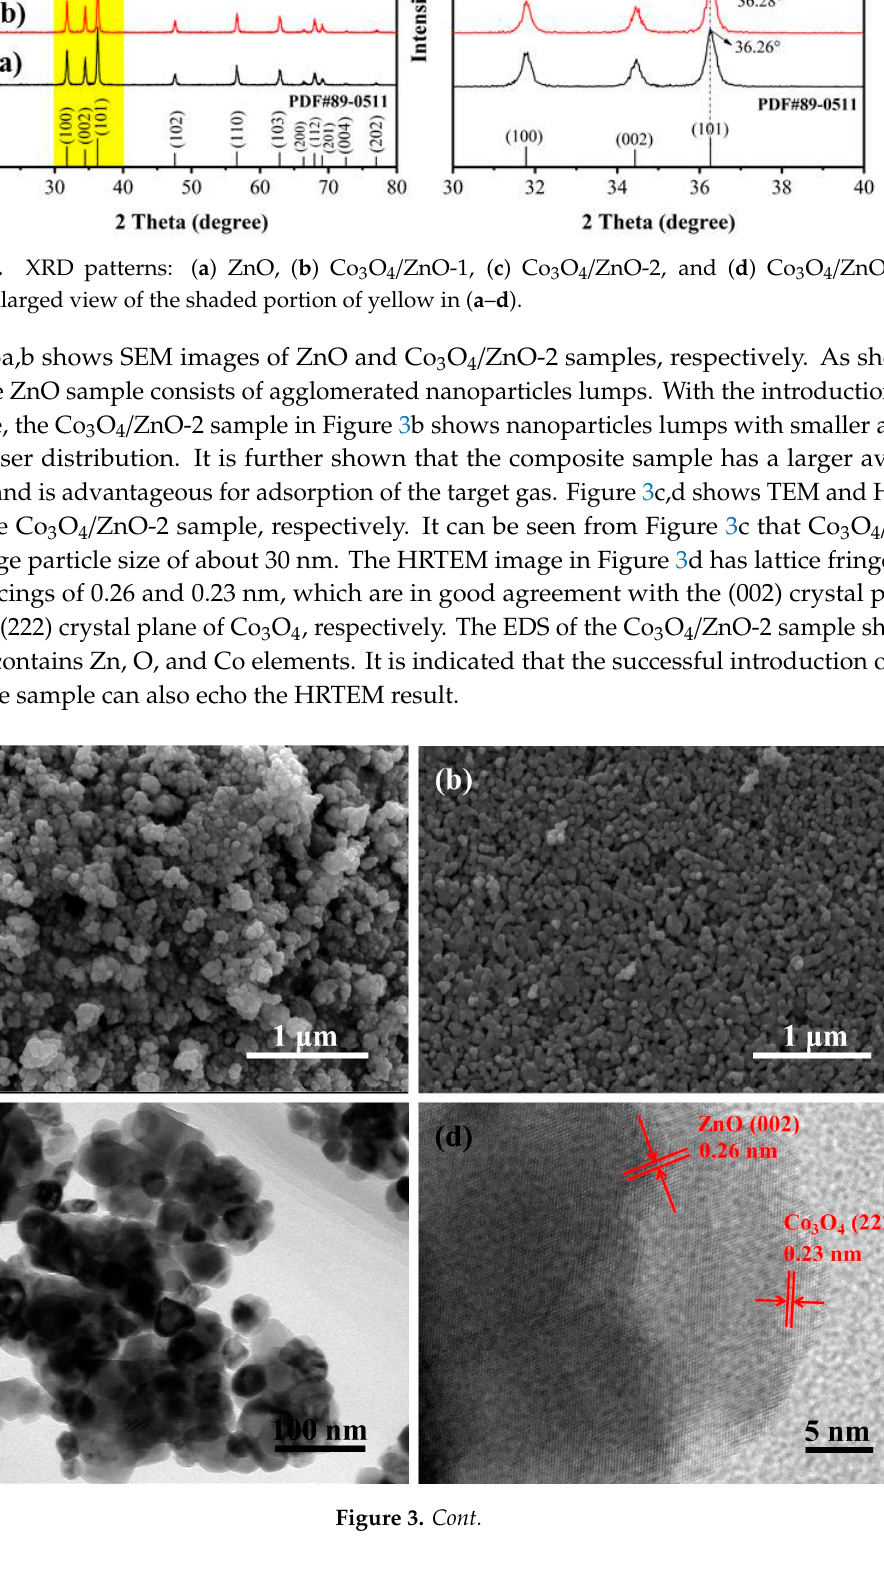
Figure 3. Field emission scanning electron microscopy images of ( a ) ZnO, ( b ) Co 3 O 4 /ZnO-2; ( c , d ) transmission electron microscopy and high resolution transmission electron microscope images of Co 3 O 4 /ZnO-2; ( e – g ) the energy dispersion spectrum of Co 3 O 4 /ZnO-2 (The two opposite arrows in Figure 3d were used to emphasize the spacing of the two parallel lines as the lattice spacing). The pore structures of ZnO and Co 3 O 4 /ZnO-2 were tested by N 2 adsorption–desorption instrument. The type IV adsorption isotherm results in Figure 4a indicate that the two samples have the mesoporous structure. Figure 4b shows that the pores of the sample are mainly about 16 nm. The Co 3 O 4 /ZnO-2 sample still has pores in the range of 32 nm, and even the maximum pore diameter is about 36 nm. These larger pores are favorable for gas adsorption and diffusion. At the same time, the calculated BET surface areas of ZnO and Co 3 O 4 /ZnO-2 were 17.733 and 21.150 m 2 g − 1 , respectively. The larger specific surface area and pore size of Co 3 O 4 /ZnO-2 means that there are more available areas to facilitate gas adsorption and surface reaction, which will help its gas sensitivity.